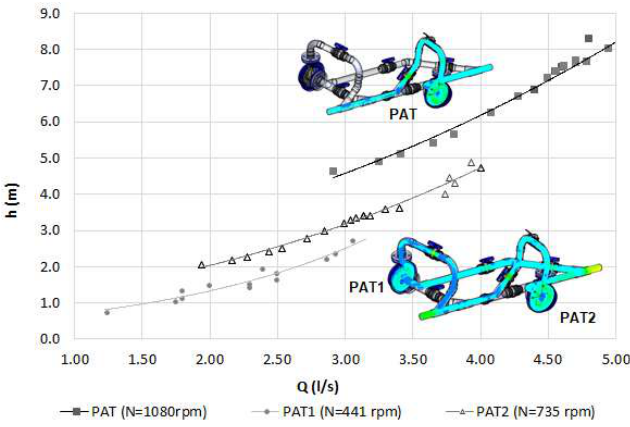
Figure 6. Experimental PATs’ operating conditions used in the CFD model.